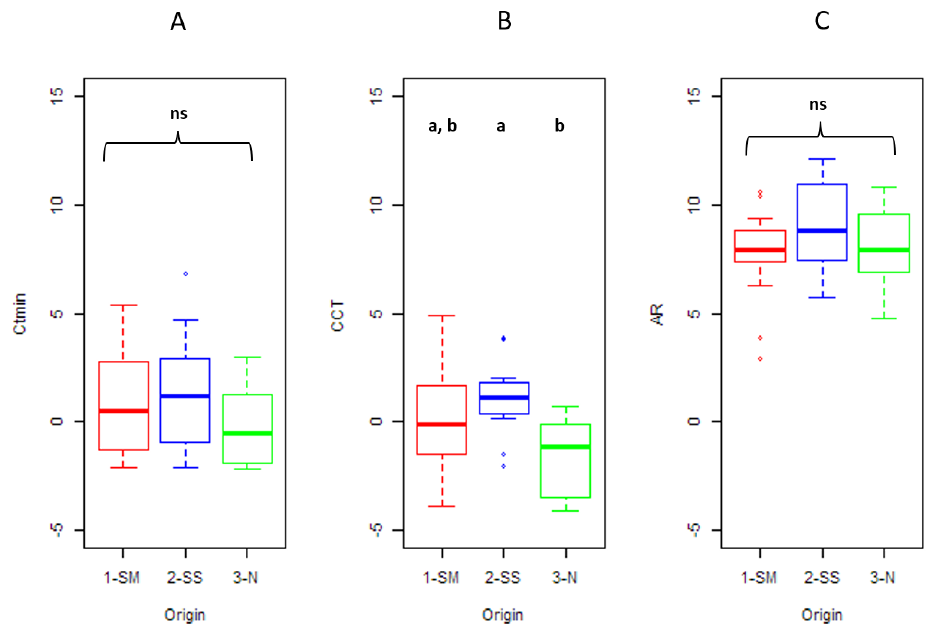
Figure 3. Influence of the variable “Origin” on the three thermal tolerance indices: CTmin ( A ), ( B ) and AR ( C CCT ( B ) and AR ( C ).